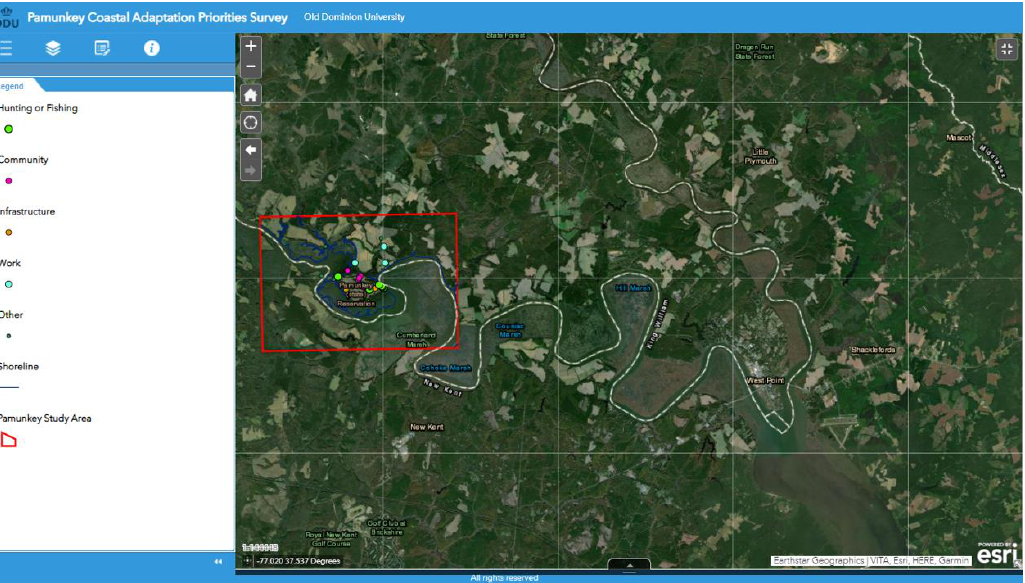
Figure 2. Heritage Sites and Shoreline of the Pamunkey Reservation Study Area and Confluence of Tributaries into the York River from the Web App.